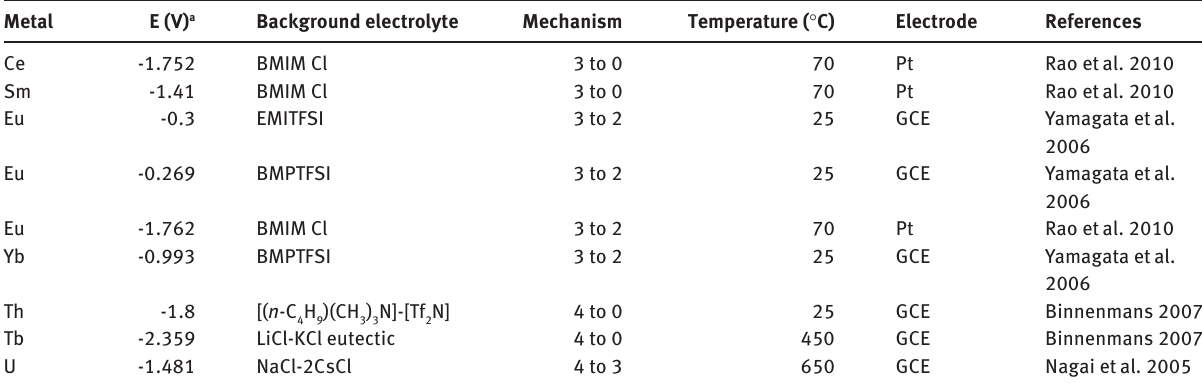
Table 6 Summary of electrochemical data of Ln and An in nonaqueous solution.